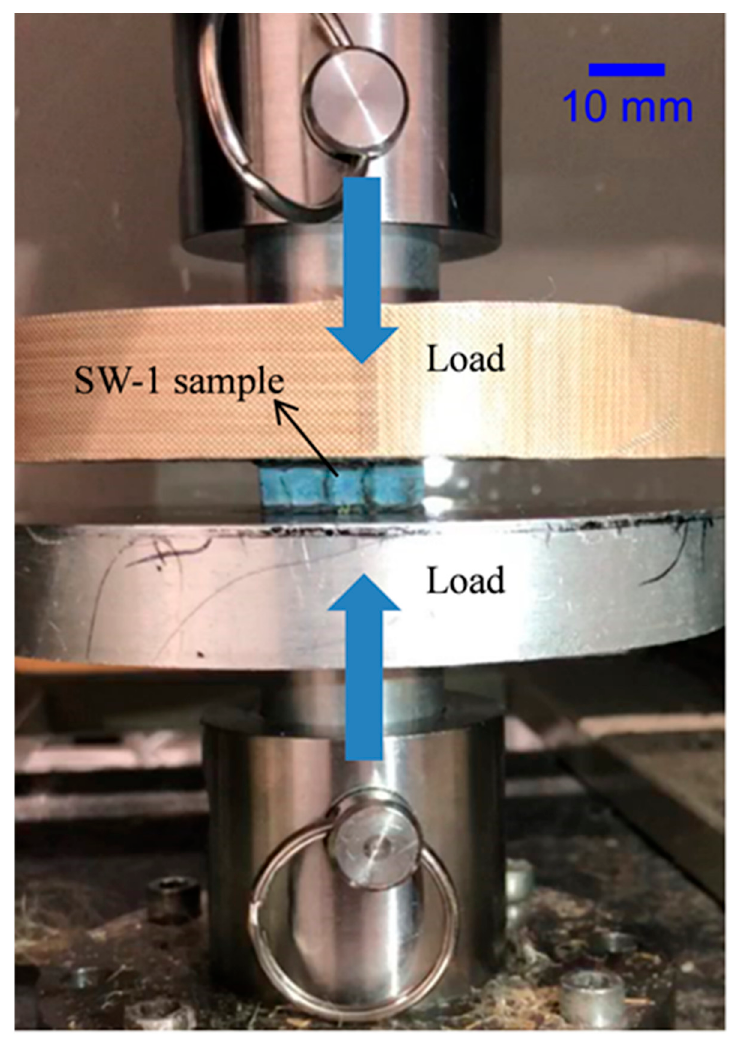
Figure 3. Compressive test device.